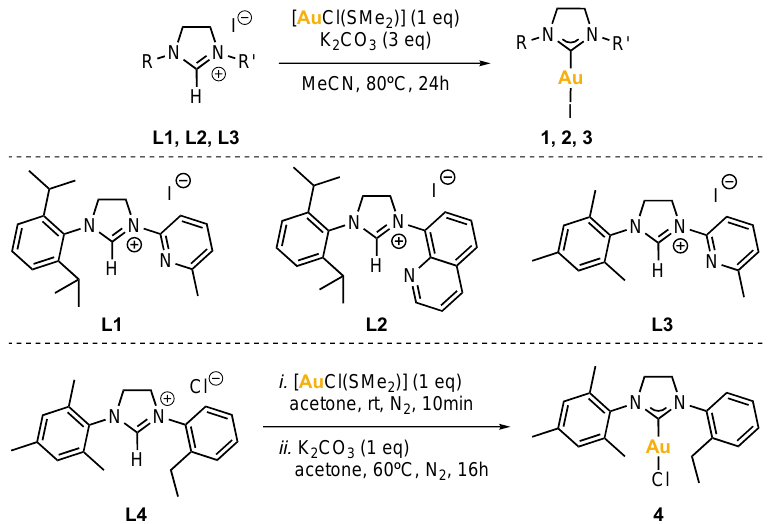
Figure 2. Synthesis of complexes 1 – 4 from the respective imidazolinium salt ligand precursors L1 – L4 .